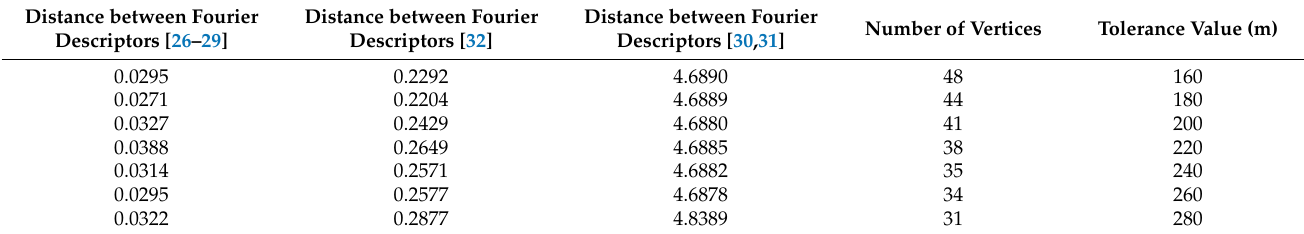
Table 7. Distances between Fourier descriptors for line #1027.